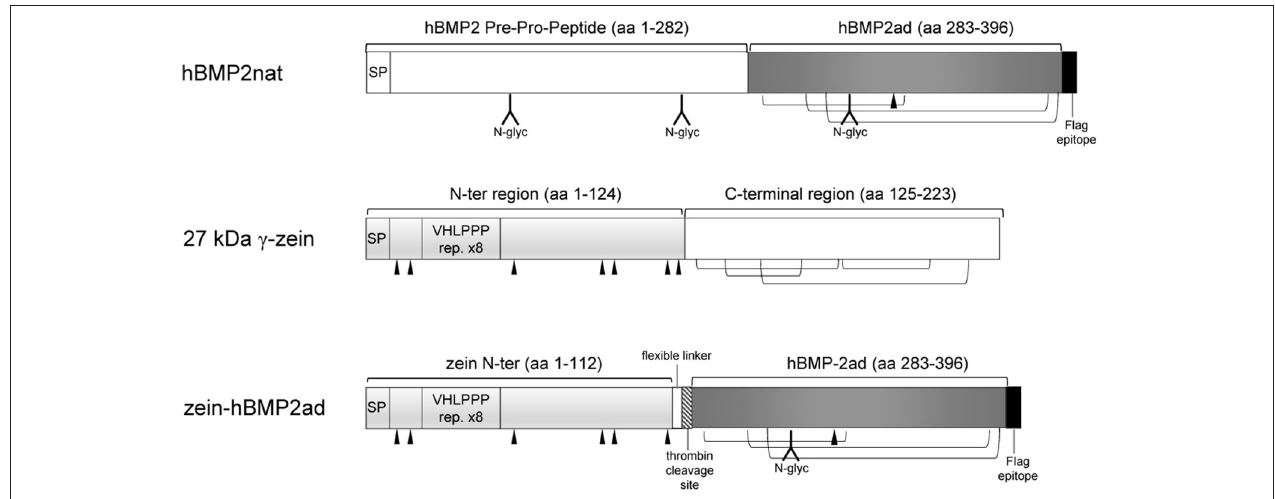
FIGURE 1 | Schematic representation of hBMP2nat, 27 kD γ -zein, and zein-hBMP2ad fusion. Dark gray box: human BMP2 active domain (ad); light gray box: 27 kD γ -zein N-terminal domain; hatched box: thrombin consensus cleavage site; black triangles: cysteine residues involved in interchain-disulfide bridges. N-glycosylated sites in hBMP2 are indicated. Intrachain disulphide bridges in hBMP2ad and in the C-terminal region of 27kD γ -zein are indicated. SP: Signal Peptide. Expected Molecular Mass: hBMP2nat, 45.8kD; hBMP2ad, 14kD; 27 kD γ zein, 23.7kD; zein-hBMP2ad,